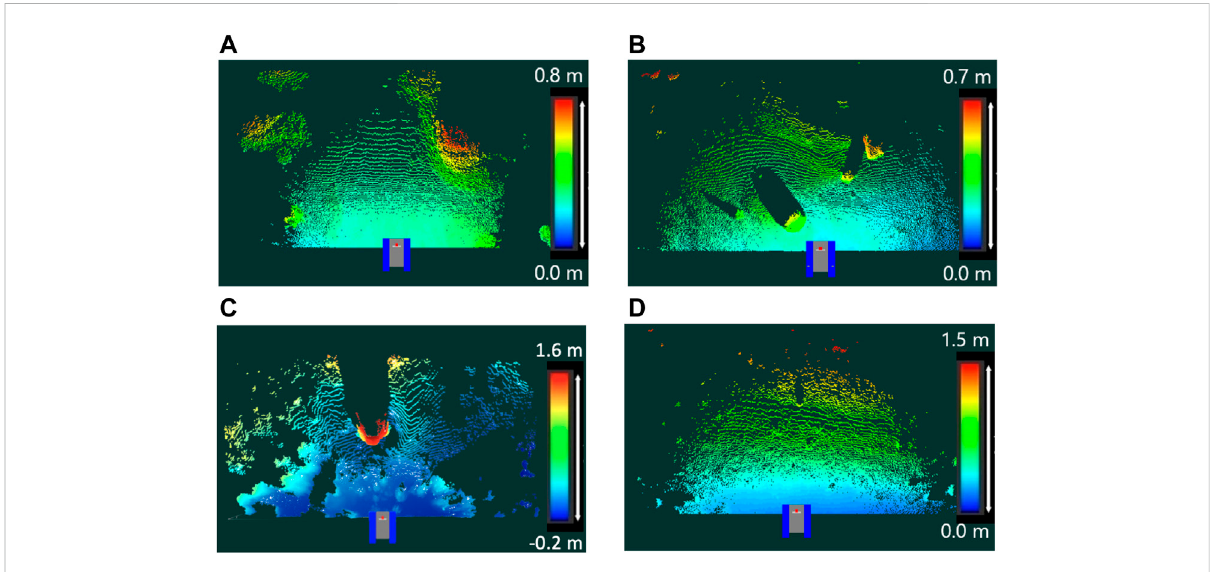
FIGURE 10 Typicalterrainmapsforsimulation.Theinitialpositionissetatthescanningpointillustratedbythe2Dmodeloftherovertestbed. (A) Flatterrain: roughness 0.083 m, (B) Rocky terrain: roughness 0.123 m, (C) Rough terrain: roughness 0.234 m, (D) Sloped terrain: roughness 0.257 m.